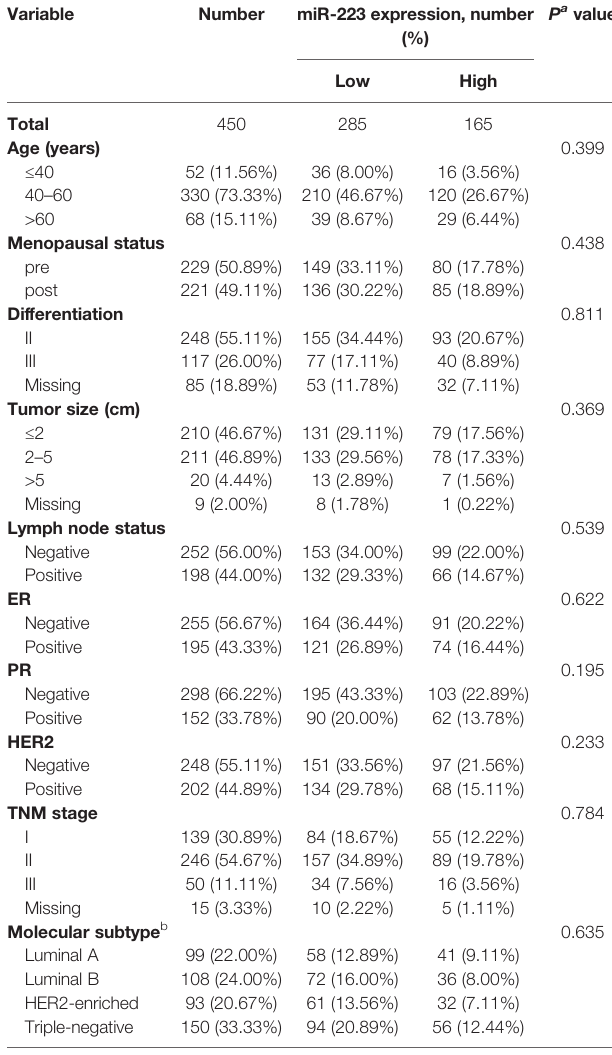
TABLE 1 | Characteristics of the study